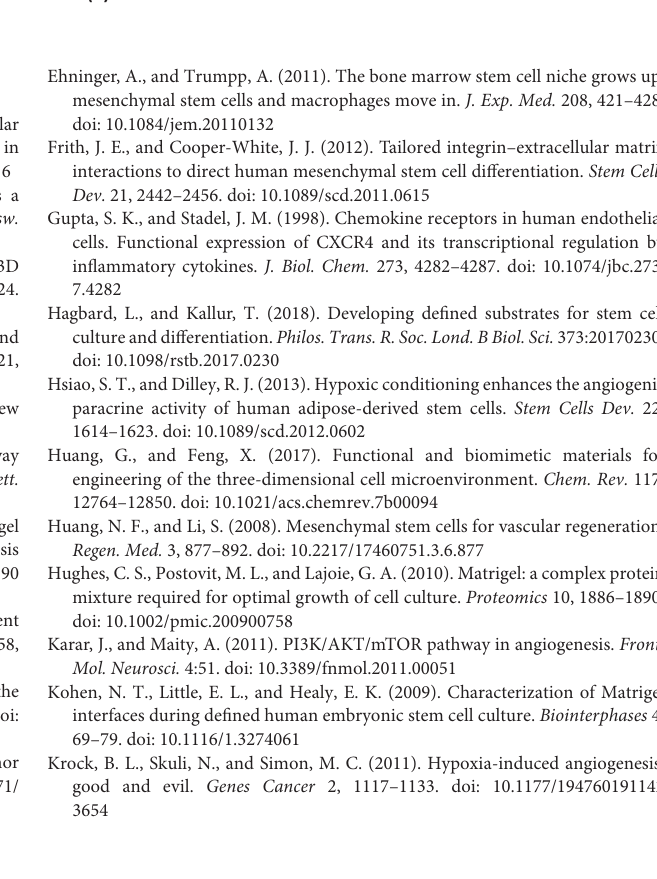
Supplementary Figure 1 | Endothelial sprouting of HUVECs monocultures and HUVECs/MSCs co-cultures after 48 h in different areas of Matrigel- and PhenoDrive-Y-coated wells (A) , MSC spheroid formation on Matrigel at 18 and 48 h (B)